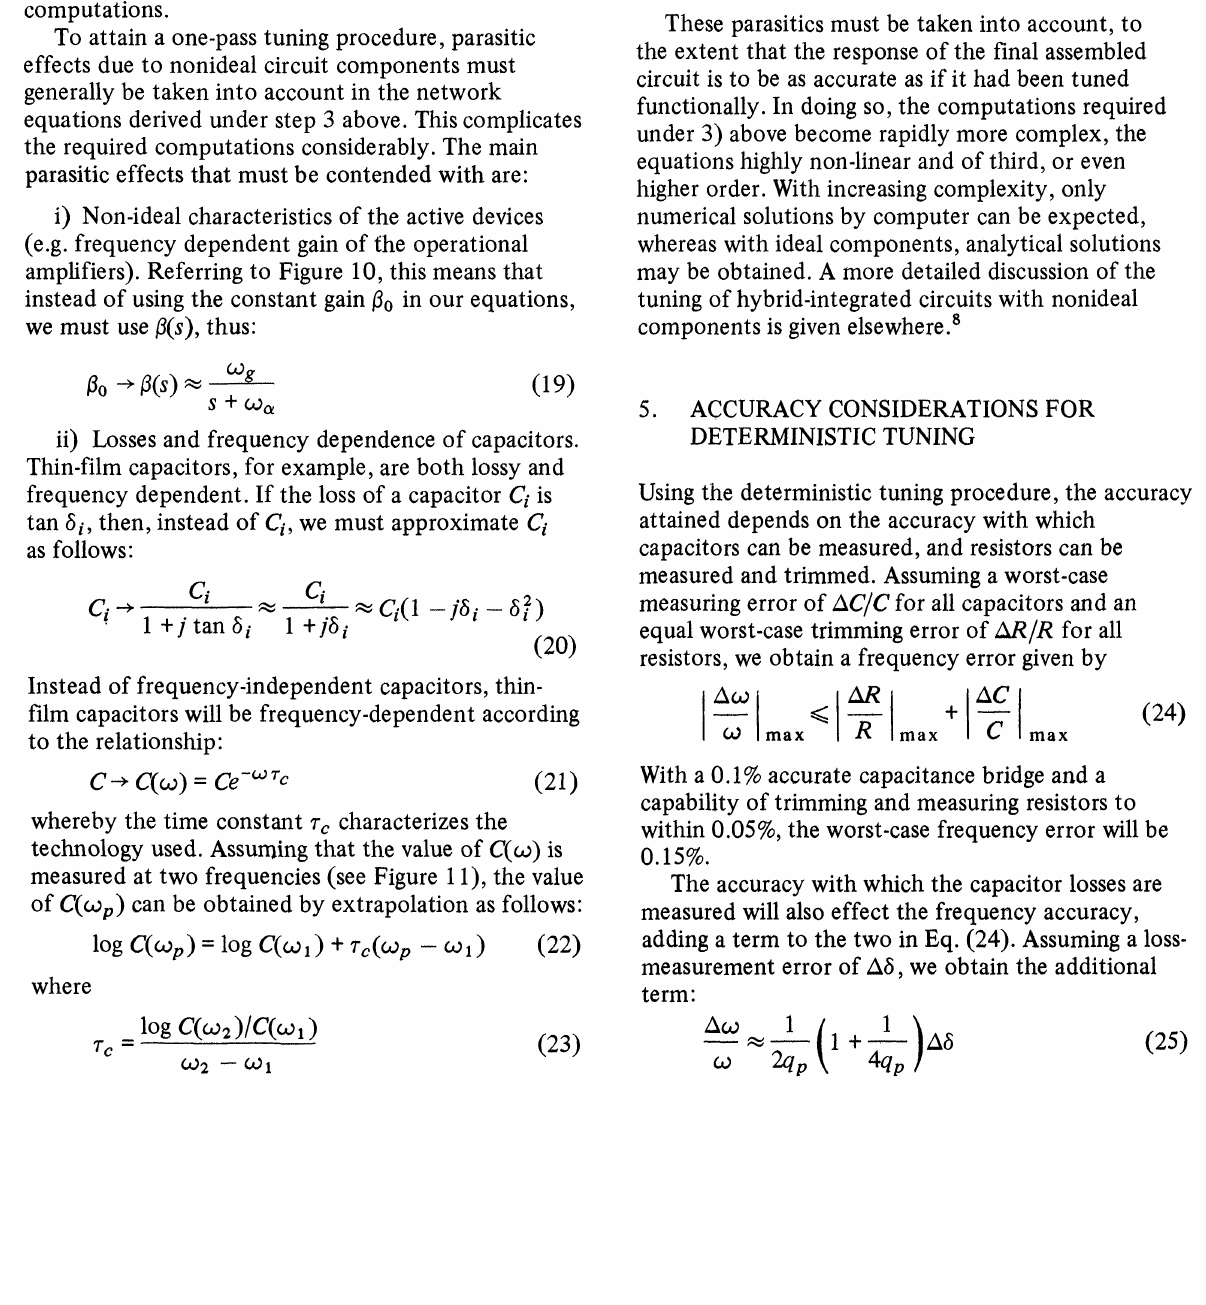
FIGURE 10 Frequency-dependent gain of an operational amplifier.